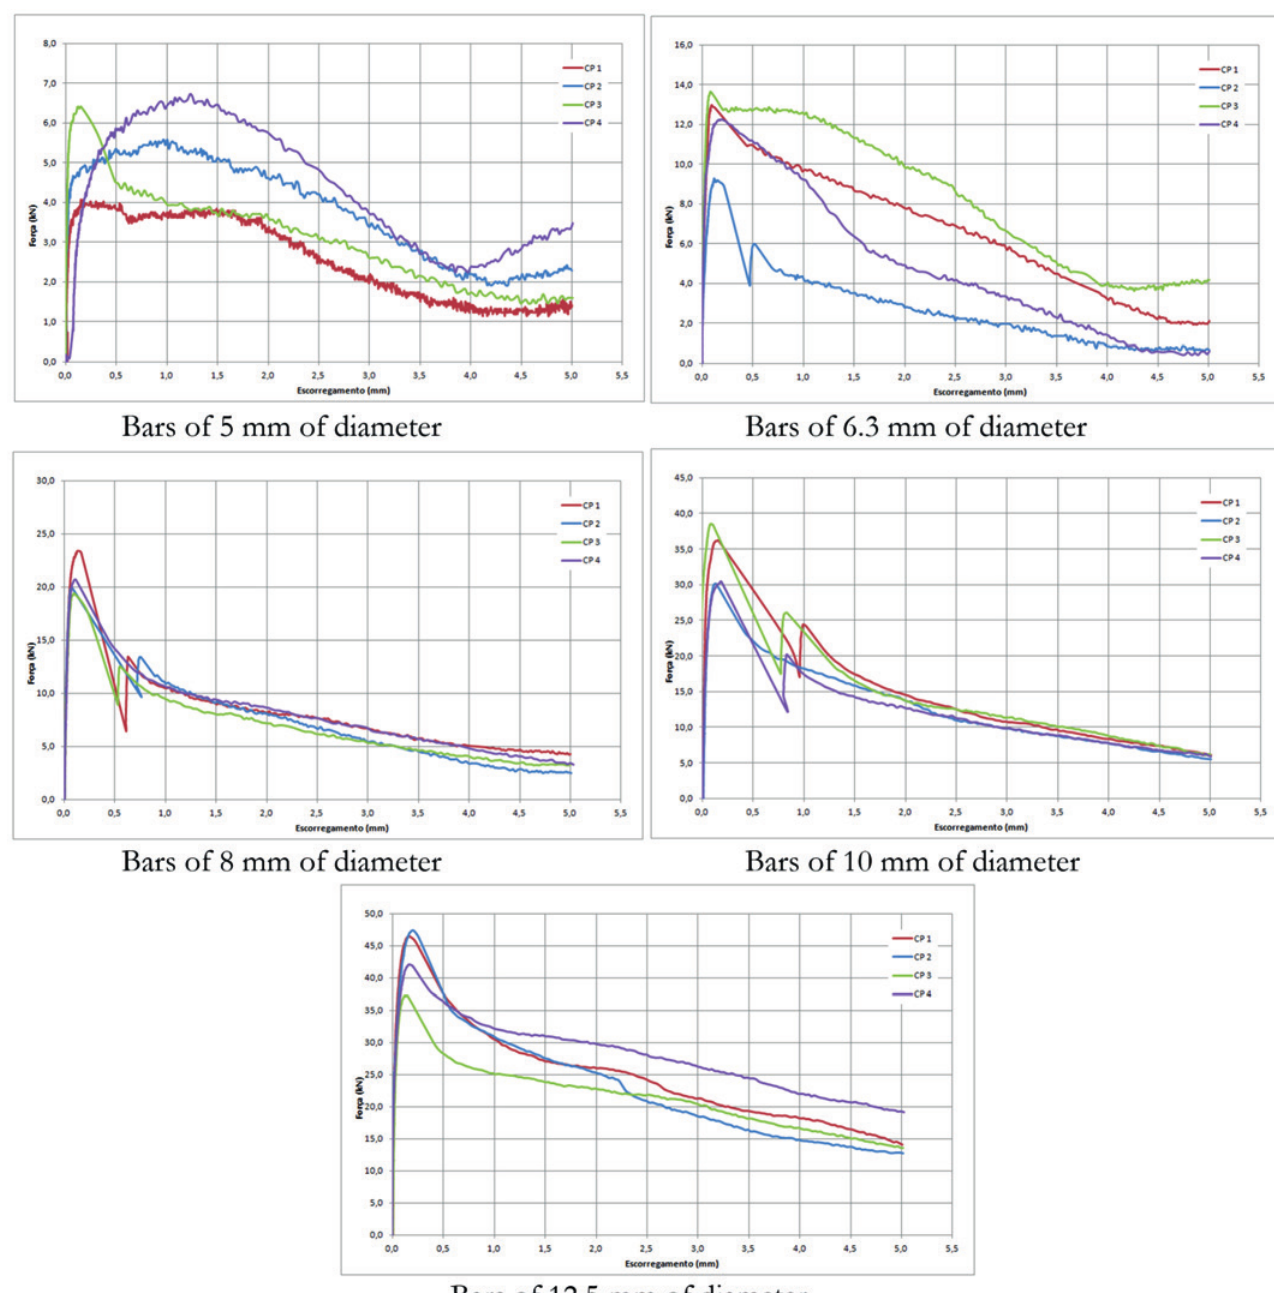
Curves of force versus sliding of the 1st batch of